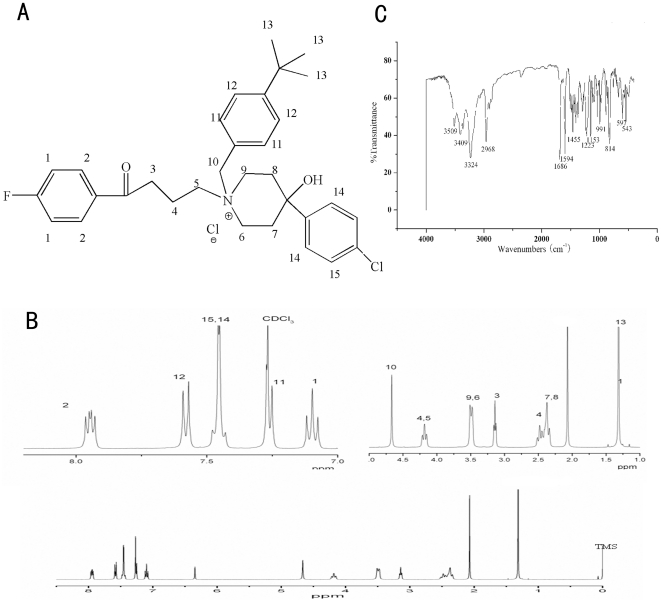
The chemical structure of 16c (A); 400 MHz 1H NMR spectrum of 16c in CDCl3 (B); Infrared Spectroscopy of 16c (C).